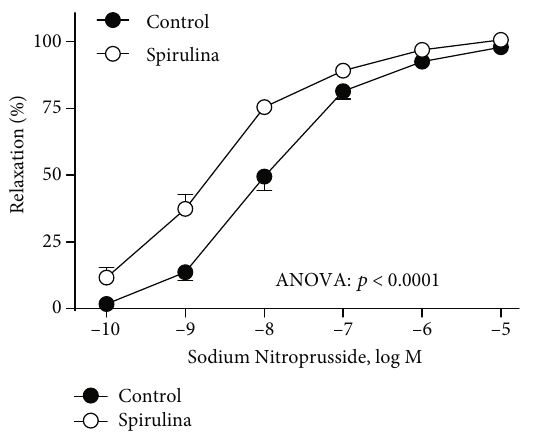
Figure 2: E ff ect of the aqueous Spirulina extract incubation on the concentration-response curve to the NO donor sodium nitroprusside in aortic segments from SHR. Results ( means ± SEM ) are presented as a percentage of inhibition of the contraction elicited by 0.1 μ M noradrenaline. Number of animals: 5-7. The statistical signi fi cance is indicated in the graph.